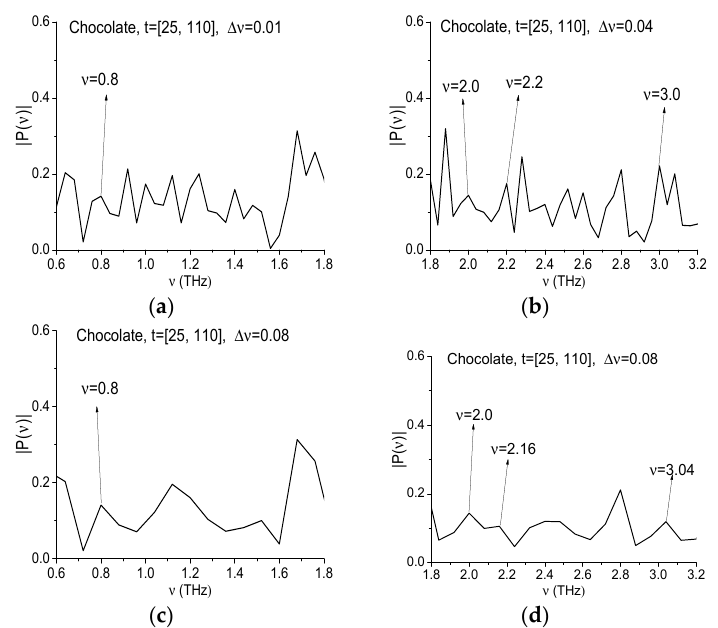
Figure 17. Signal Chocolate spectrum in the frequency ranges ν = [0.6, 1.8] ( a ); [1.8, 3.2] ( b ) calculated with the spectral resolution Δ ν = 0.04 THz ( a , b ), 0.08 THz ( c , d ).